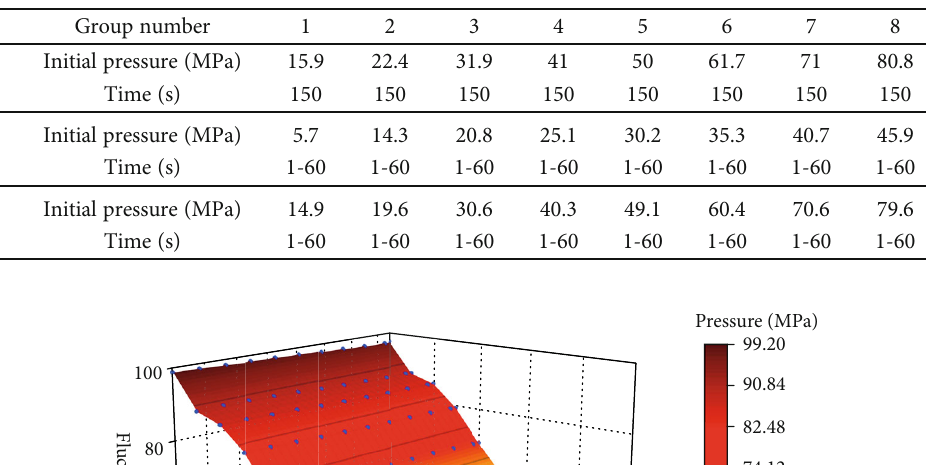
Table 2: Parameters used in the pressure leakage rate